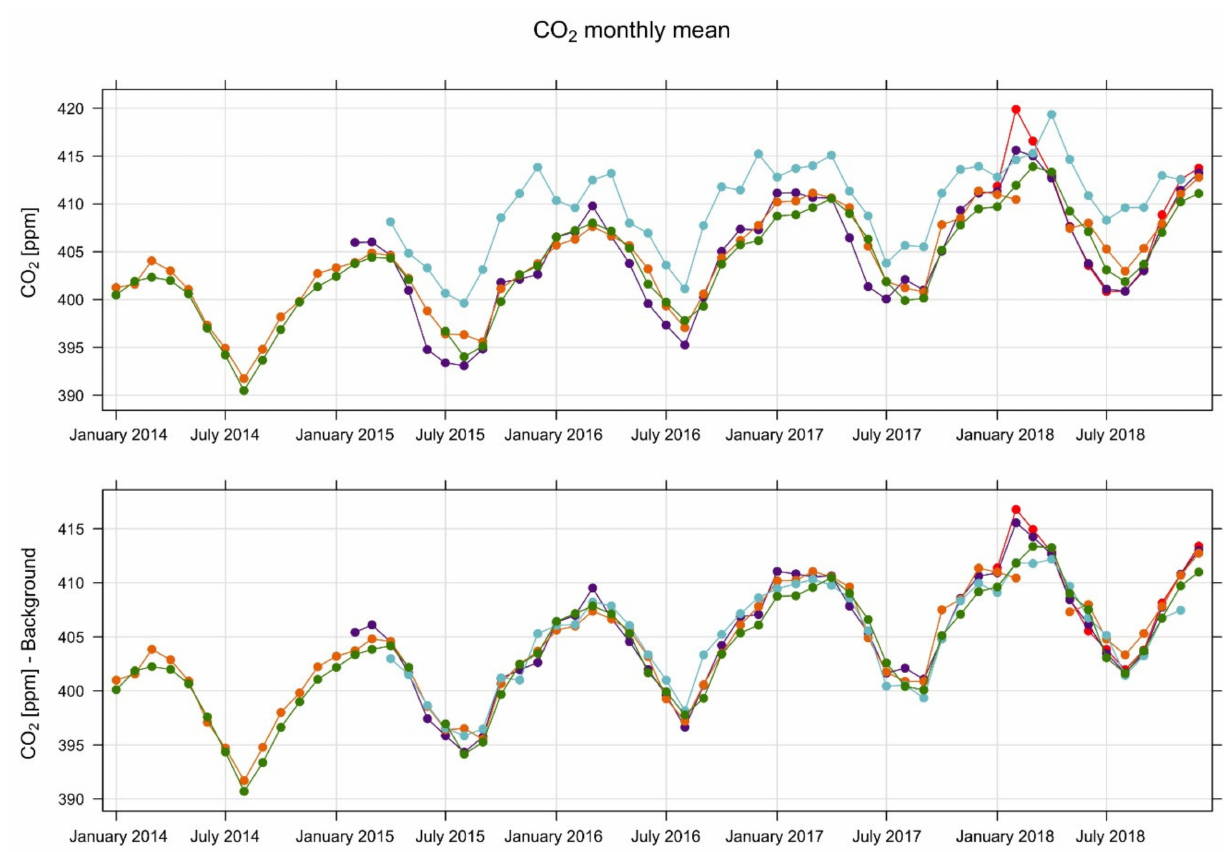
Figure 4. Top panel: time series of monthly mean CO 2 for PRS (green), CMN—ISAC (red), CMN—CAMM (purple), CGR (light blue) and LMP (orange). Bottom: same as above, but for background